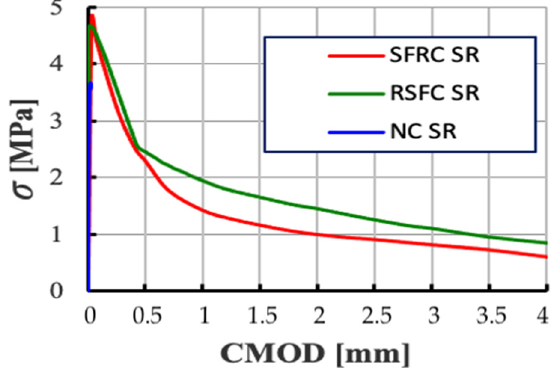
Figure 17. Comparison of diagrams of σ -CMOD relationships for concrete without fibres (NC) and with fibres (SFRC and RSFRC) obtained during the residual strength test for CMOD up to 4 mm (3-point test).